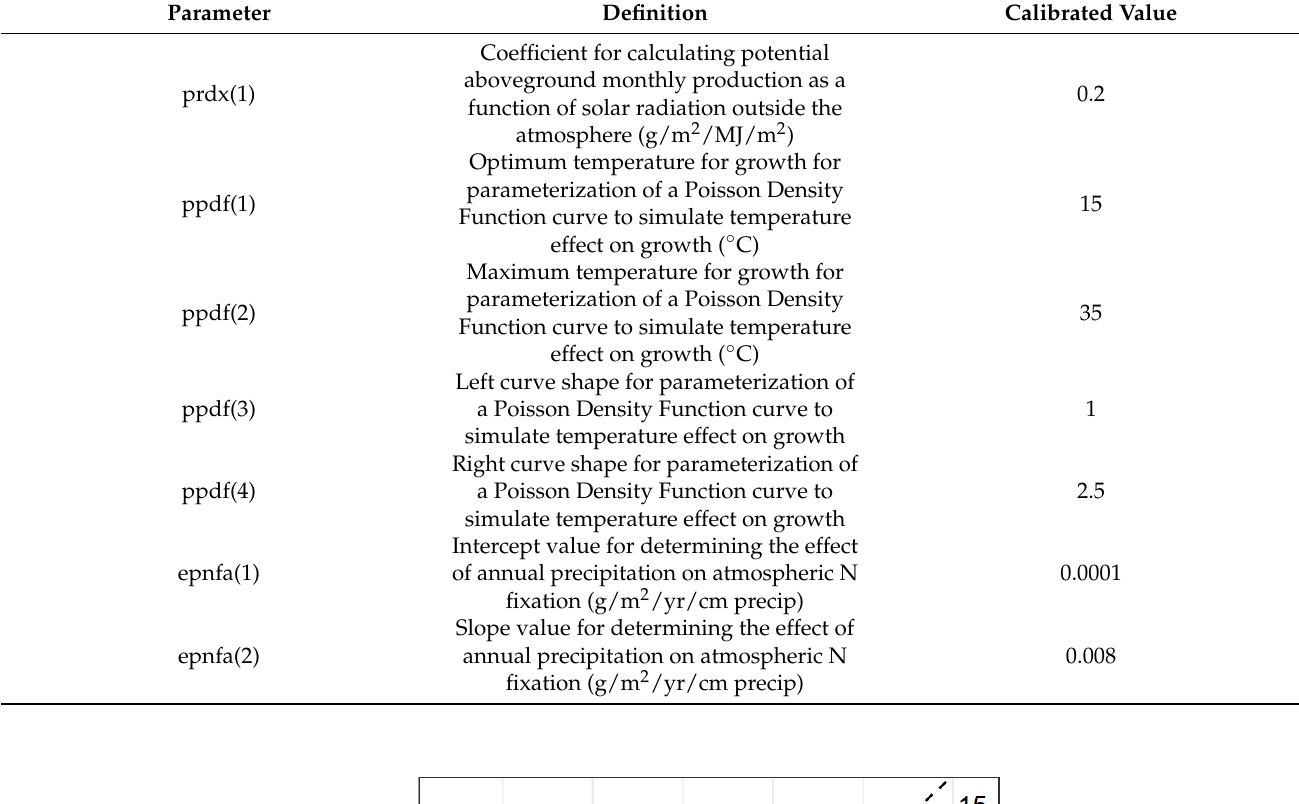
Table A3. Model parameters that were calibrated with comparison to empirical biomass and NDVI. The same parameter values were used for simulations using Century and RPM.